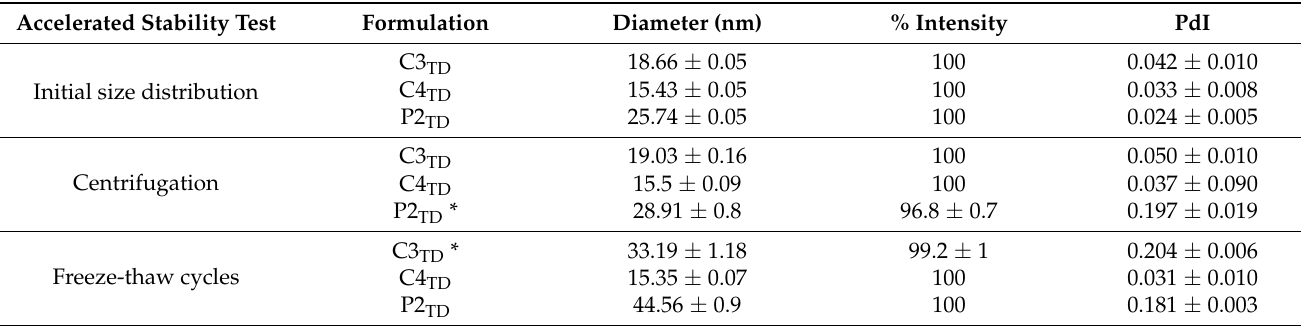
Table 5. Globule size distribution by intensity of 50-fold diluted TD-loaded NE formulations after accelerated stability